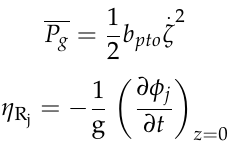
( b ) Figure 3. Convergence test for the number of nodes per wavelength with Sommerfeld radiation condition ( 𝜔 = 3.2 rad/s): ( a ) heave added mass; ( b ) heave radiation damping coefficient. 3.2. 3D-FR-NWT with Radiation Boundary Conditions Based on the optimal mesh system, in this study, we applied three types of radiation boundary conditions (1: Sommerfeld radiation condition (SRC), 2: artificial damping zone (ADZ), 3: combined radiation condition between the SRC and ADZ) and compared their performance. First, the SRC was applied only at the sidewall boundary surface. Figure 4 compares the hydrodynamic coefficients (added mass and radiation damping coefficient) and wave excitation vertical forces on the hemispheric heaving buoy. The results were in agreement with the WAMIT results, except for under low-frequency conditions. This is because low- frequency radiated waves (long waves) are reflected at the end boundary of the compu- tational domain (see Figure 5). Hence, in the case of the rectangular calculation domain, if only the Sommerfeld radiation condition is applied, the low-frequency wave near the apex cannot be properly radiated on the end boundary. Therefore, when numerical modeling